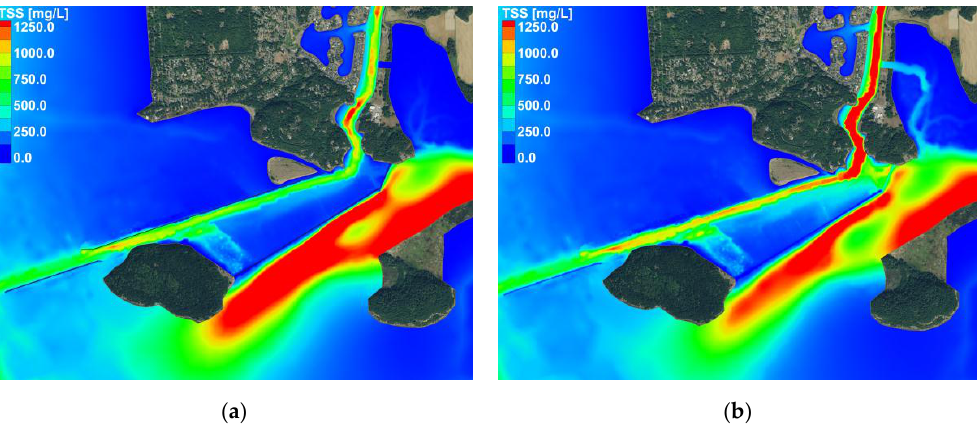
Figure 15. Time averaged total suspended sediment (TSS) distribution (20 days) for ( a ) baseline conditions and ( b ) McGlinn Causeway restoration, SCN-2.